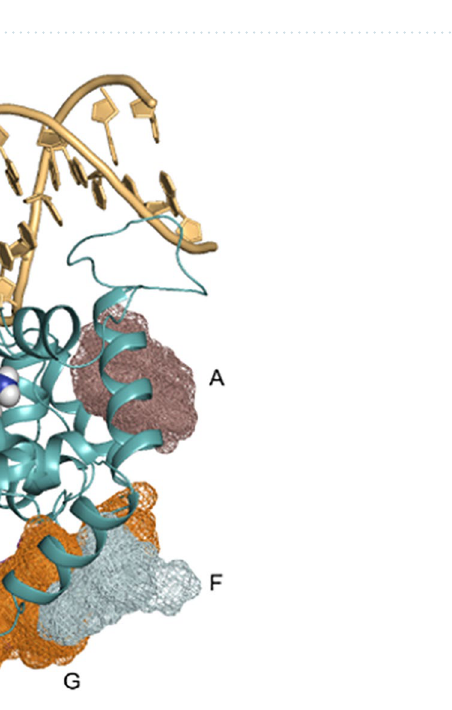
Figure 4. 19 F NMR Binding Experiments. ( a ) Non 1 H-decoupled 19 F NMR spectra of compound VI in the presence of different concentrations of OGG1. Gradual line broadening of the 19 F NMR resonance as OGG1 concentration is increased indicates an interaction with OGG1. ( b ) Non 1 H-decoupled 19 F NMR spectra of 100 μM compound VI in the absence of OGG1 (top), presence of 16 μM OGG1 (middle) and presence of 16 μM OGG1 and 100 μM compound VII (bottom). The line narrowing effect observed on the bottom spectrum of Compound VI when compared to the middle spectrum is indicative of the two compounds competing for the same binding site. ( c ) Bar graph of the average peak heights extracted from the 19 F NMR spectra (N = 2) of compound VI obtained with various OGG1 concentrations shown in panel c (dark grey on the left) and in the presence of 16 μM OGG1 plus 100 μM of a displacement compound, VII - X (light grey on the right). For the displacement experiments, the peak height of compound VI can be observed to increase, reflecting a line narrowing of its NMR resonance.